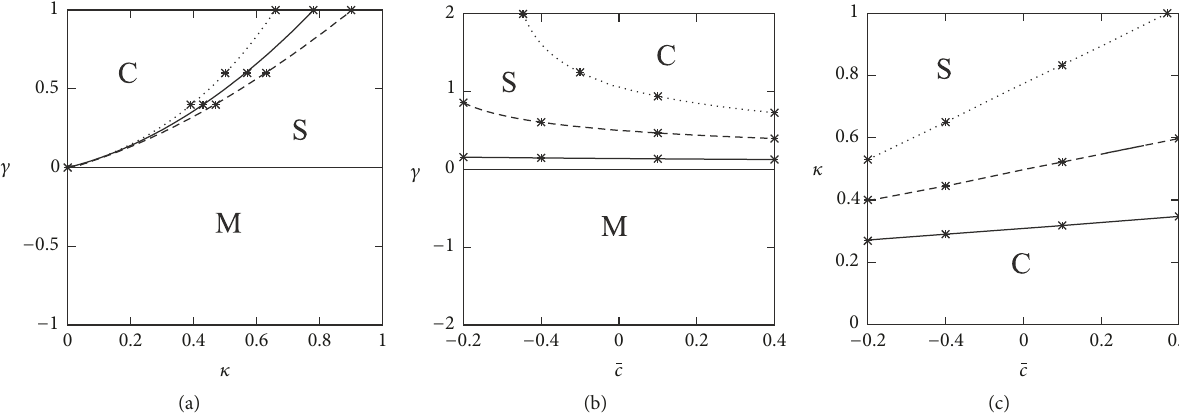
Figure 5: Phase diagram of spot motion. 𝑎 = 𝑏 = −1 and 𝑏 𝑠 = 0.05 . Data are obtained by the analysis of (96). M, S, and C in the figure represent regions of no motion, straight motion, and circular motion, respectively. The mark ∗ represents the data obtained by the simulation of the reduced tensor model. (a) Phase diagram in the 𝜅 - 𝛾 plane. The solid, dashed, and dotted curves correspond to the cases of 𝑐 = 0 , 0.2 , and −0.2 , respectively. The upper (lower) region of each curve corresponds to the region of circular (straight) motion, and the region 𝛾 ≤ 0 corresponds to the region of no motion. (b) Phase diagram in the 𝑐 - 𝛾 plane. The solid, dashed, and dotted curves correspond to cases of 𝜅 = 0.2 , 0.5, and 0.8, respectively. The region across each curve is the same as in (a). (c) Phase diagram in the 𝑐 - 𝜅 plane. The solid, dashed, and dotted curves correspond to the cases of 𝛾 = 0.25 , 0.5, and 1.0, respectively. The upper (lower) region of each curve corresponds to the region of straight (circular)